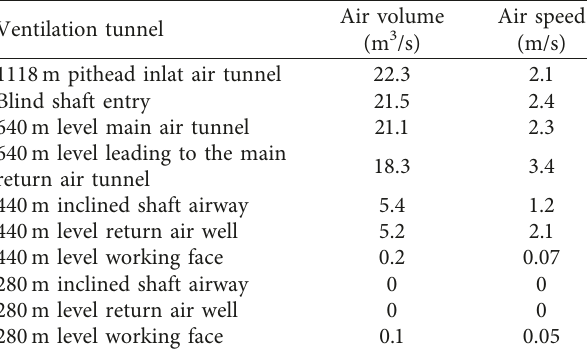
Table 1: Air volume of underground ventilation shaft in 1118m pit of Jinqu Gold